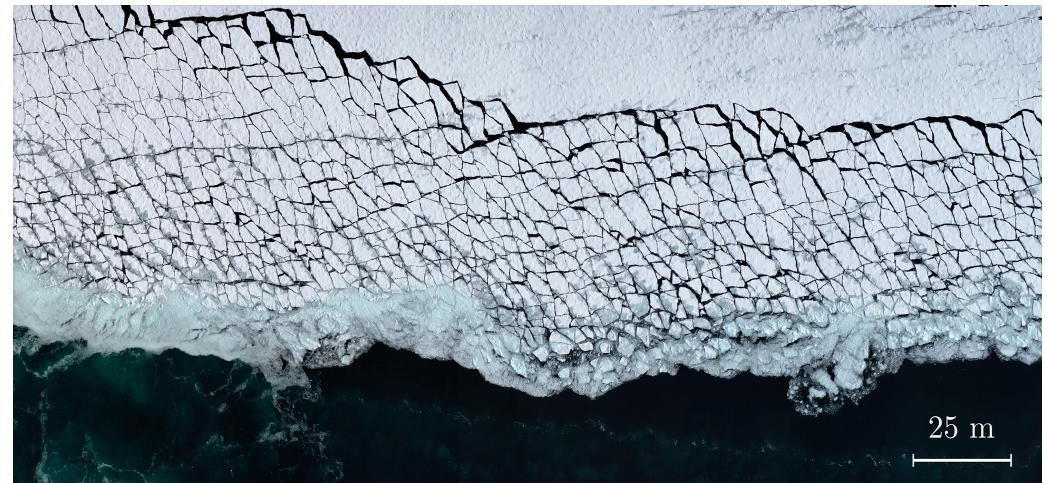
Figure 7. Breakup resulting from the GSL experiment. The ship sailed along the horizontal axis of the